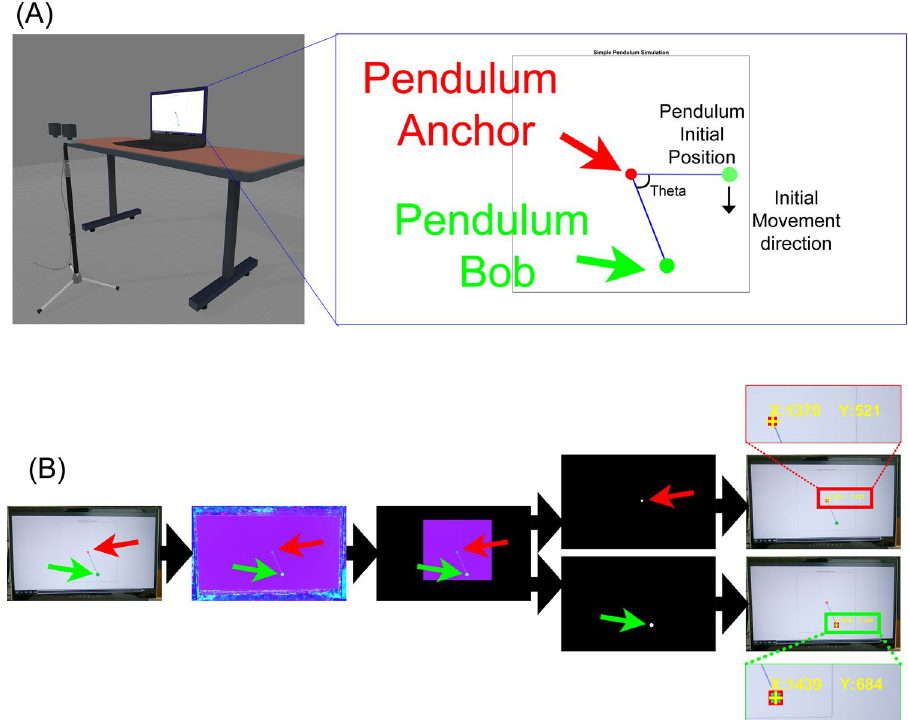
Figure 3. Experiment 2 setup and object detection process. ( A ) Experimental setup. The action cameras on the mount were placed in front of the laptop PC monitor. A simulated pendulum was played on a laptop 300 Hz fresh rate. The pendulum simulation includes the pendulum anchor (red circle), rod (blue line), and bob (green circle). The pendulum started at a pi/2 angle and played for 10 s. ( B ) Object detection process. Green and red circles were separately detected from the cropped HSV